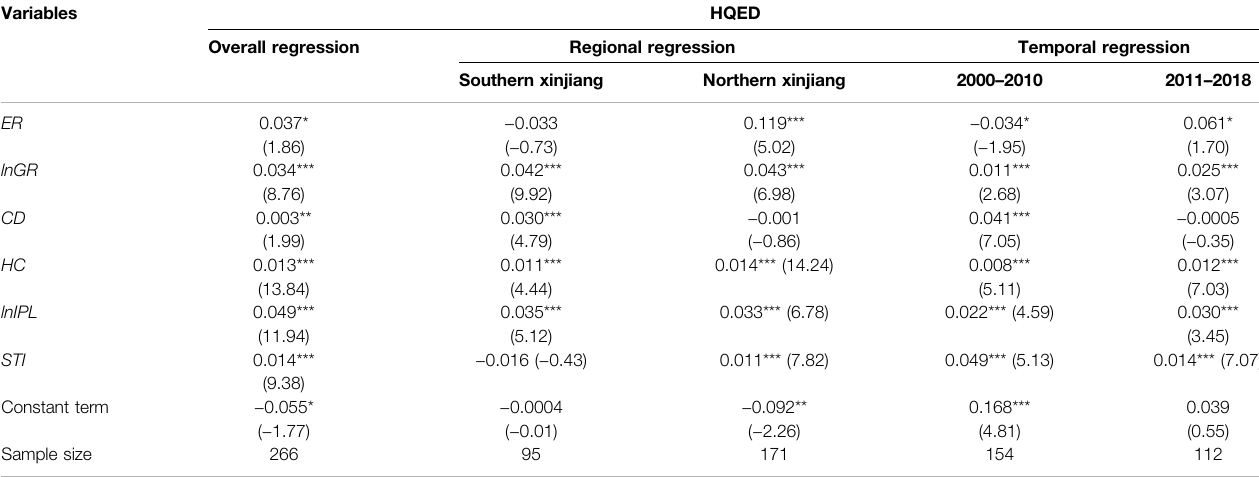
TABLE 4 | The impact of environmental regulation on high-quality economic development in